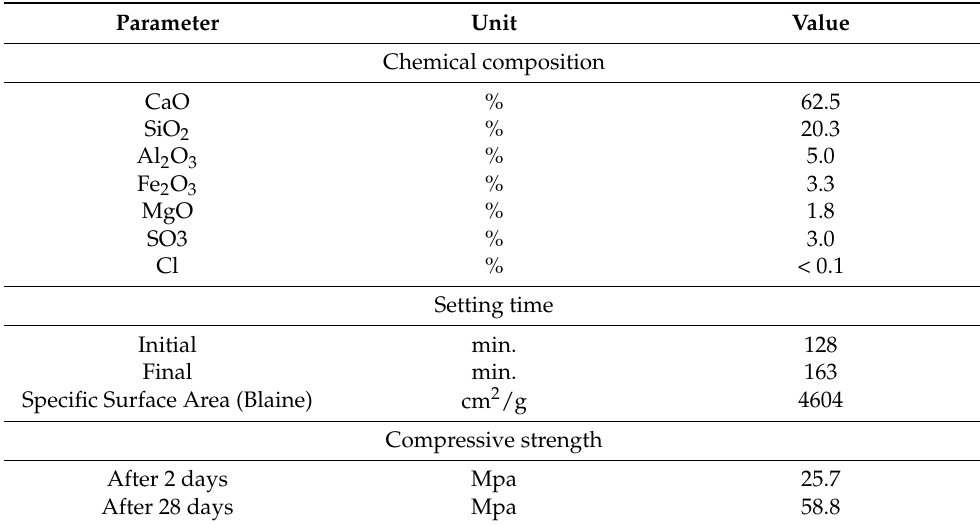
Table 1. The Portland cement CEM I 42.5R